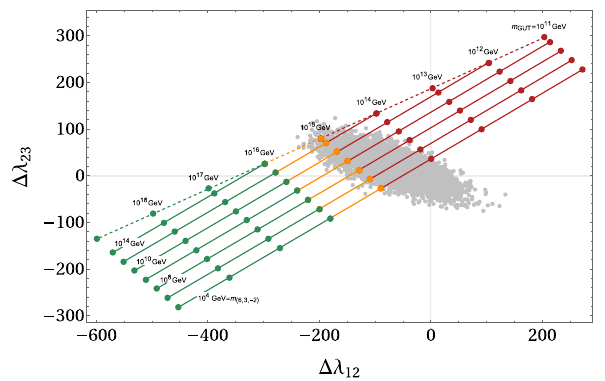
Fig. 7 Prospects for gauge unification in scenarios with light ( 3 , 3 , − 2 ) scalars. Scalars in the ( 3 , 3 , − 2 ) mediate proton decay and therefore have to be heavier than 10 10 GeV [52]. By taking threshold , 2 ] (light gray points) into 20 , 2 ] (light gray points) into account we find corrections with R ∈ [ 1 20 (cid:11) 10 15 . 7 GeV. This scenario is that the SO ( 10 ) scale at most M max SO ( 10 ) therefore on the verge of being excluded by proton decay experiments